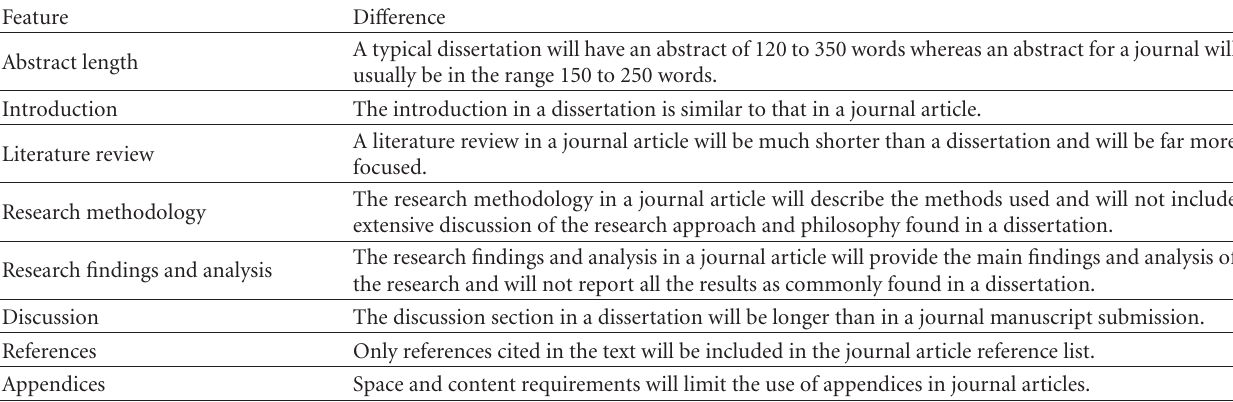
Table 6: How dissertations di ff er from journal articles.